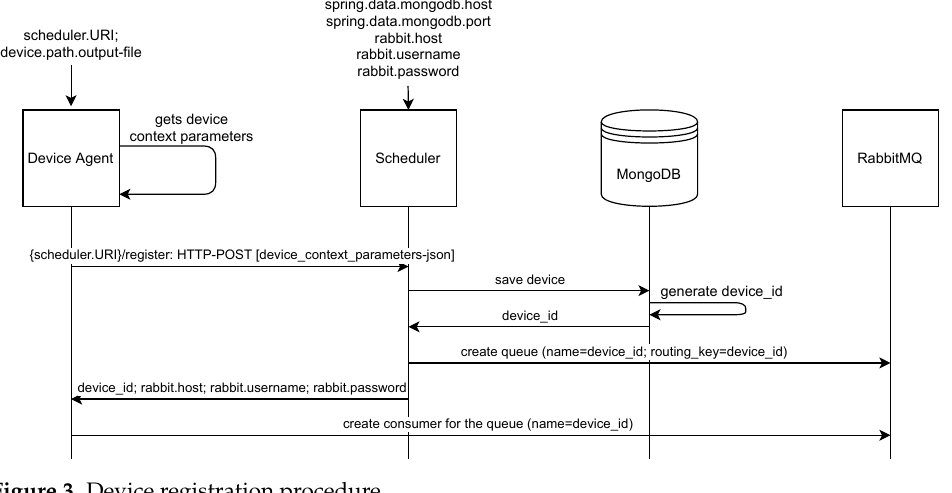
Figure 3. Device registration